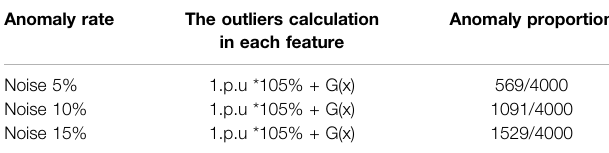
TABLE 2 | The noises injection of simulated dataset. Anomaly rate The outliers calculation in each feature